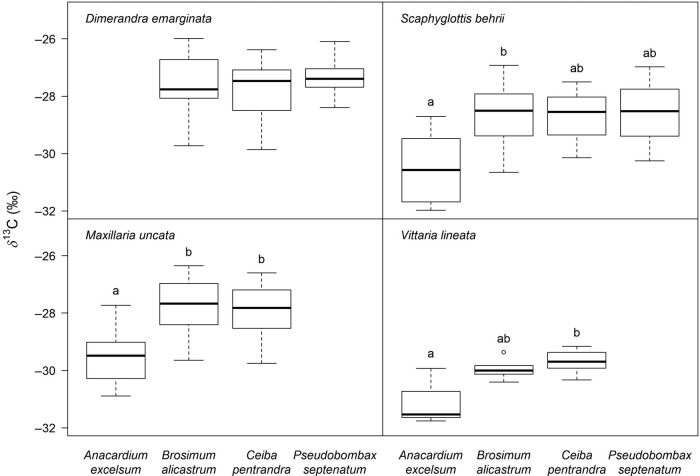
δ13C values for Dimerandra (66), Maxillaria (40), Scaphyglottis (27) and Vittaria (15) sampled on different tree species. Letters indicate significant differences (ANCOVA with plant size as the covariate: Maxillaria P < 0.05, F(1,36) = 6.2 and Scaphyglottis P < 0.05, F(3,22) = 5.4; ANOVA: Vittaria P < 0.05, F(2,11) = 5.5).